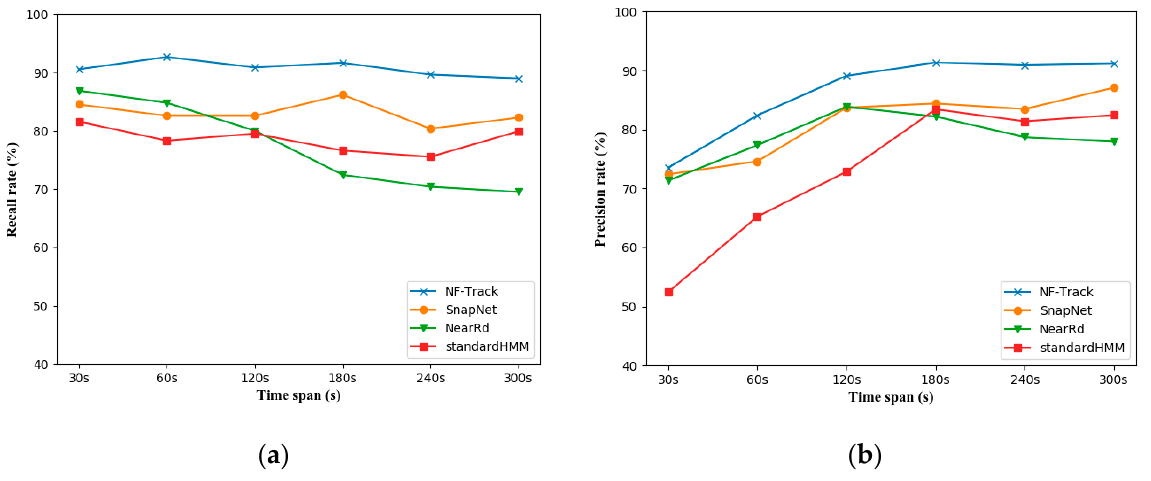
Figure 18. Comparison of map-matching accuracy on the real dataset for various update spans. ( a ) Recall rates and ( b ) precision rates.